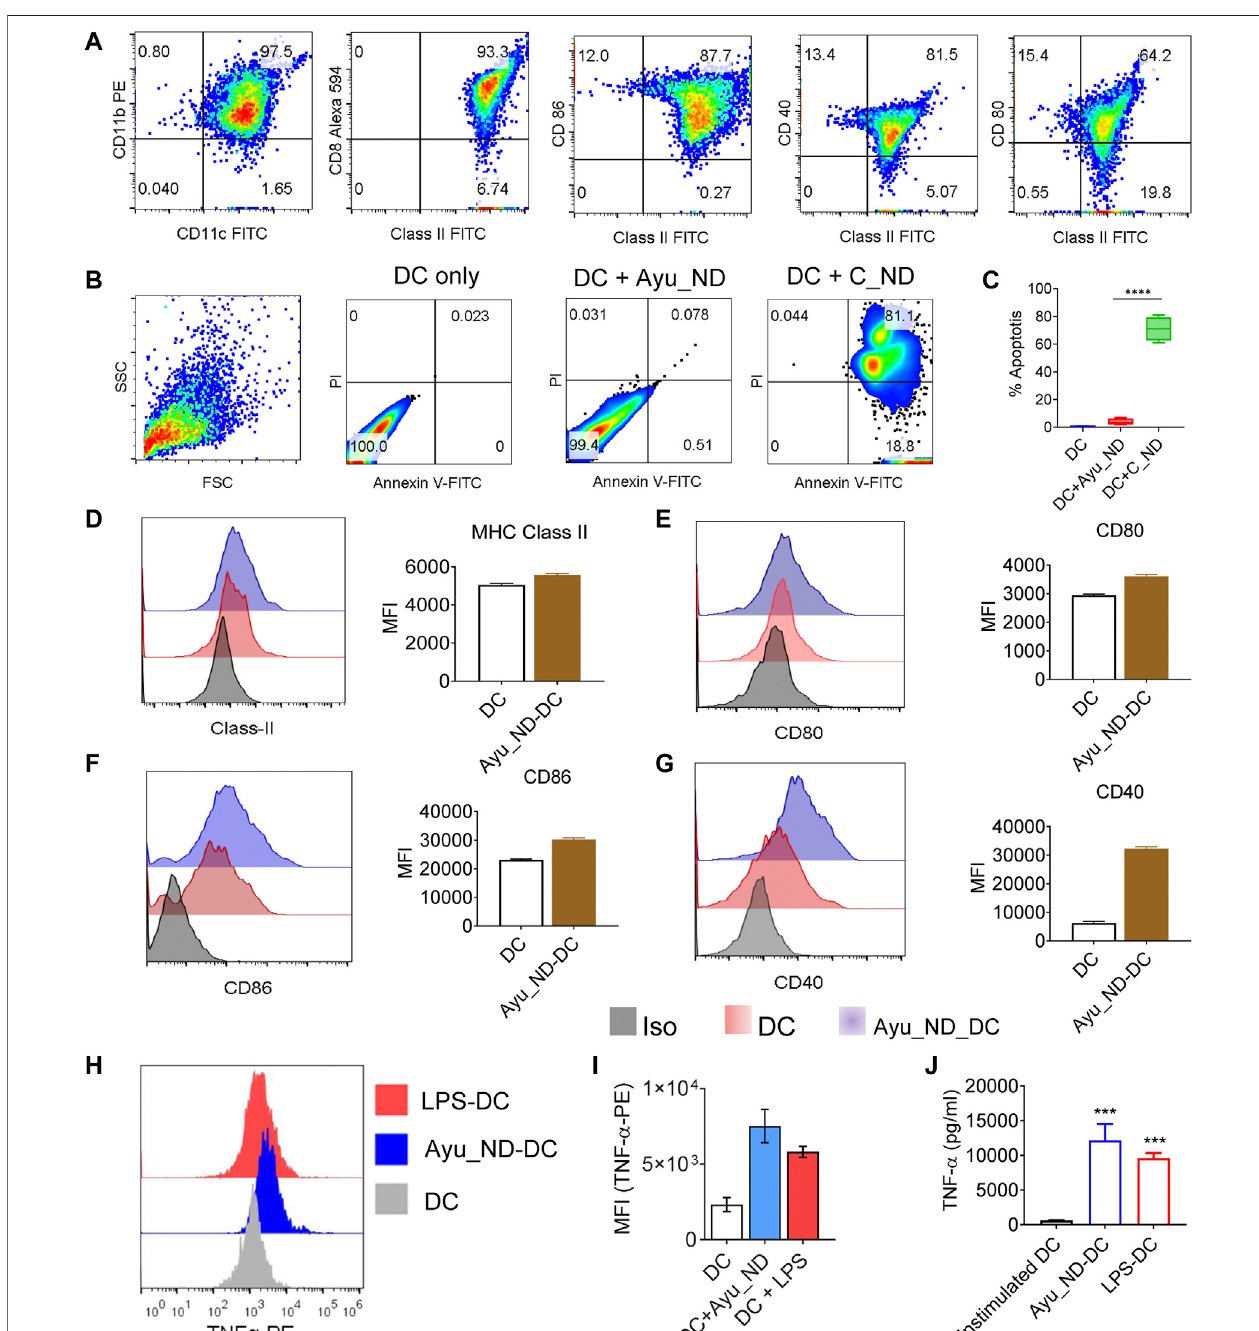
FIGURE4| Ayu_NDinducesdendriticcellactivationandenhancesDC-derivedTNF- α expression.CD11c+/CD11b+DCswereassessedby fl owcytometryforthe expression of MHC class II, CD80, CD86 and CD40 (A) . DCs were treated with either medium alone or with 200 μ g/ml Ayu_ND or C_ND (B) for 120 h, and the percent apoptosiswasdeterminedbyFACSanalysisindicatedintheblueboxesofthedouble-positivequadrate.%ApoptoticDCsweredocumentedby fl owcytometricanalysis (C) . The expression of MHC class II, CD80, CD86 and CD40 was assessed by fl ow cytometry in 10 μ g/ml Ayu_ND-treated CD11c+/CD11b+ DCs (D – G) . The mean fl uorescence intensity (MFI) of class II and costimulatory molecules in dendritic cells following treatment with Ayu_ND is presented. DCs were either treated with mediumonlyortreatedwith10 μ g/mlAyu_NDorLPS(5 μ g/ml)todeterminetheexpressionofTNF- α by fl owcytometry (H) .MFIofTNF- α expressioninthethree-groups (I) . Estimation ofTNF- α by ELISA in the culture supernatants ofDCs following the indicated treatment (J) . The experiment wasrepeated independently four times ( n = 4) to con fi rm theresults. Represtativedot plot and histogram plots are presented here. Inbar diagarms, data arepresented asthe mean ± SD, n =6. * p < 0.05, ** p < 0.01, *** p < 0.001, and **** p < 0.0001, n = 6. In vivo inhibition or regression of long-term tumor growth by Ayu_ND generates strong CD8 + T cell immunity.